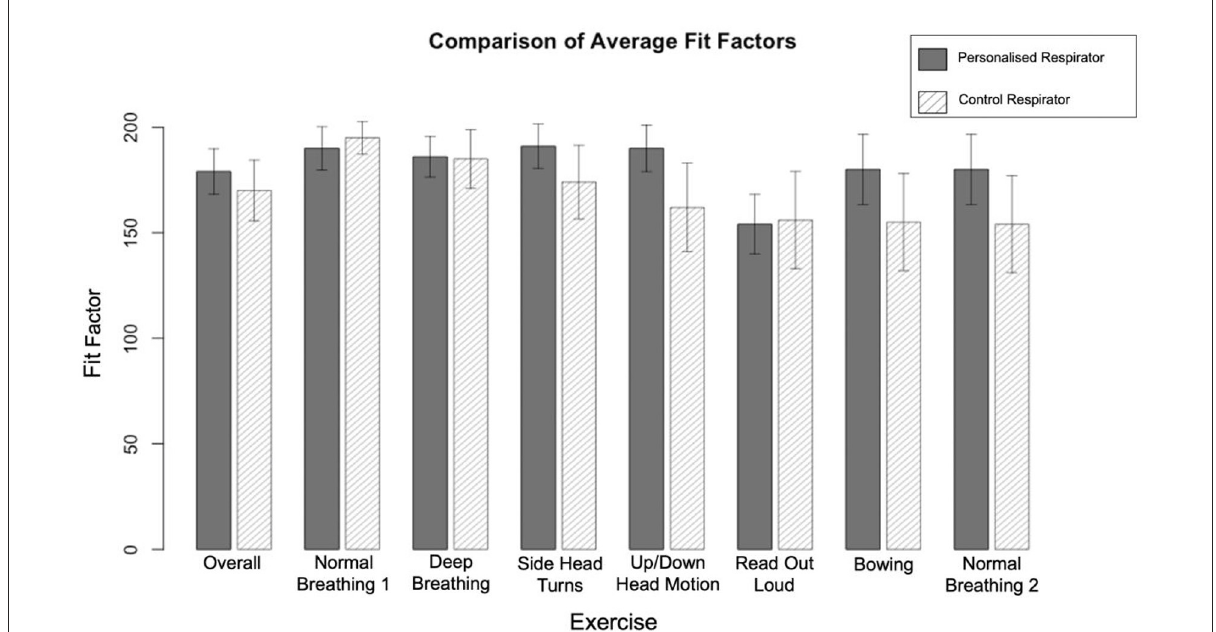
FIGURE3 Representation of location of the fit test fail points of each the Alpha Solway 3030V and the 3DPPE masks in comparison to the participants NIOSH Bivariate Panel value.